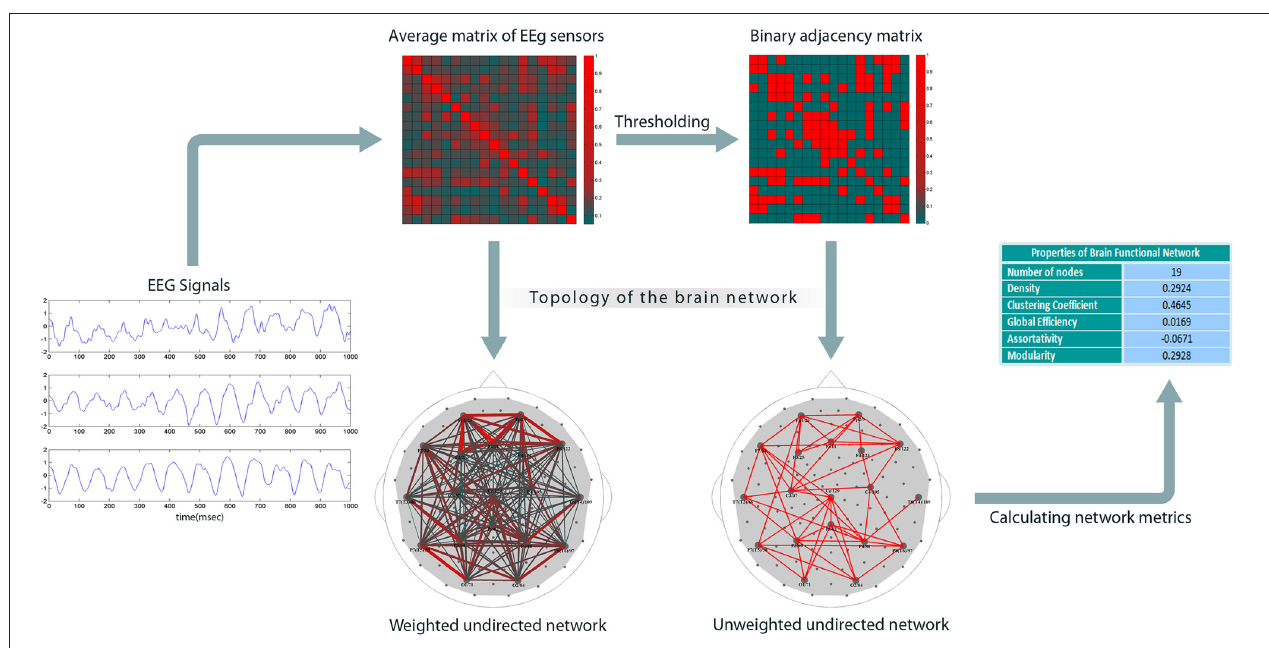
FIGURE 1 | Construction of brain networks from EEG signals. The plots on the left show sample EEGs taken over a time period of one second. The next step is to compute pair-wise correlations to obtain a weighted cross-correlation matrix (rows and columns represent the nodes). Then, the